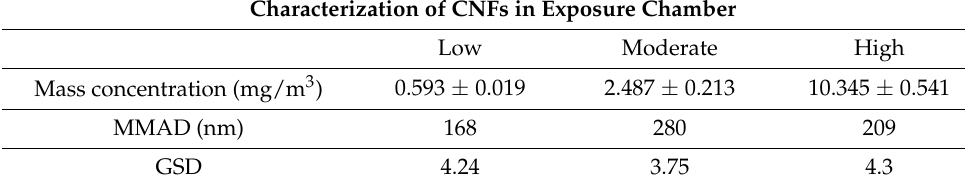
Figure 2. CNF physicochemical characteristics. Table 3. CNF mass concentrations and MMAD in exposure chamber. Table 3. CNF mass concentrations and MMAD in exposure chamber.